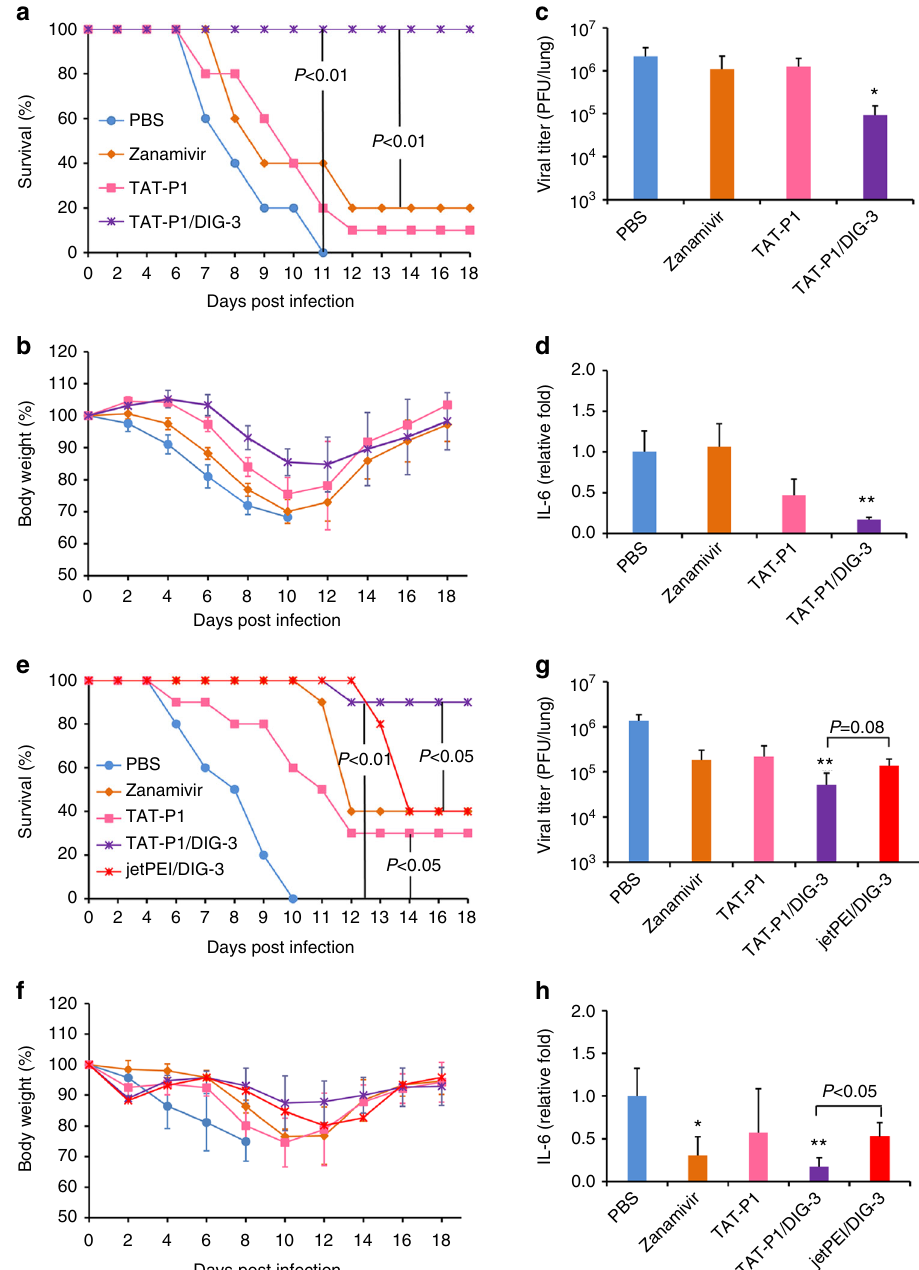
Fig. 5 TAT-P1/DIG-3 could provide prophylactic and therapeutic protection against A(H7N7) virus infection in mice. a – d Prophylactic ef fi cacy of TAT-P1/ DIG-3 against A(H7N7) virus. e – h Therapeutic ef fi cacy of TAT-P1/DIG-3 against A(H7N7) virus. For prevention, 40 μ l of PBS ( n = 10), zanamivir (50 μ g in PBS, n = 10), TAT-P1 (20 μ g in distilled water, n = 10), and TAT-P1/DIG (20 μ g/5 μ g in distilled water, n = 10) were intratracheally inoculated to corresponding mice at 48 and 24 h before viral inoculation. For therapeutic experiment, PBS ( n = 10), zanamivir ( n = 10), TAT-P1 ( n = 10), TAT-P1/DIG ( n = 10), or jetPEI/DIG (0.7 μ l/5.0 μ g in 5% glucose solution, n = 5) were intratracheally inoculated to corresponding mice at 6 and 24 h after viral inoculation. Viral titers and IL-6 in mouse lungs were detected at day 4 post infection with mean ± SD of three mice in each group. The expression of IL-6 was normalized to PBS group. * Indicates P < 0.05. ** Indicates P < 0.01 when compared with PBS group. P values were calculated by Gehan – Breslow – Wilcoxon test for survivals and by the two-tailed Student ’ s t test for viral titer and IL-6 analysis (Fig. 6b), viral titers (Fig. 6c), and IL-6 expression in mice mouse lungs when compared with PBS group. Collectively, these (Fig. 6d) when compared with PBS. In therapeutic experiment data of TAT-P1/DIG-3 anti-A(H7N7) and anti-A(H1N1)pdm09 (Fig. 6e – h), the survival of mice treated with TAT-P1/DIG-3 virus in mice demonstrated that the dual-functional TAT-P1 (93%) or zanamivir (90 %) was signi fi cantly better than that of could directly inhibit viral infection in mice and also ef fi ciently mice treated with PBS (0%) or jetPEI/DIG-3 (20%) (Fig. 6e). deliver DIG-3 into mouse lungs to exert sustained antiviral TAT-P1/DIG-3 signi fi cantly reduced body weight loss on days activity for prophylactic and therapeutic treatment. Even though 4 – 8 (Fig. 6g), viral titers (Fig. 6f), and IL-6 expression (Fig. 6h) in the prophylactic protection of TAT-P1/DIG-3 on A(H1N1) NATURE COMMUNICATIONS| (2018) 9:2358 |DOI: